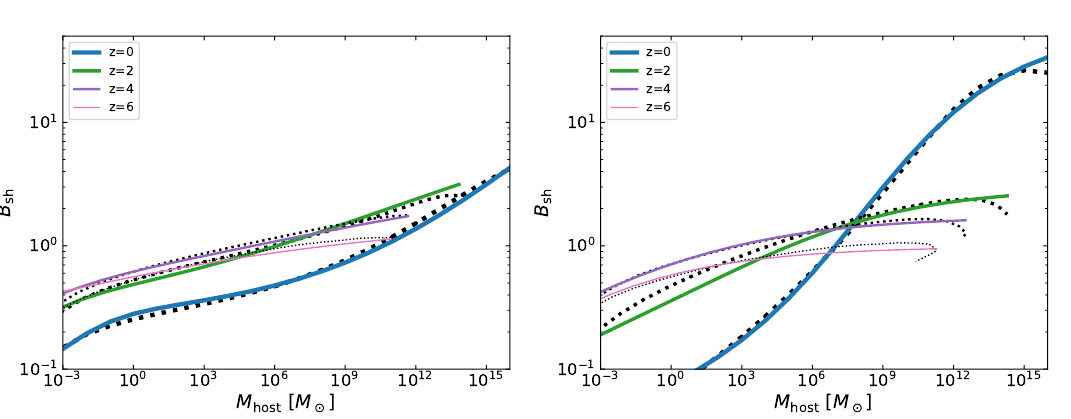
Figure A3. Comparisons between the boost factor from our calculations in Reference [50] and the fitting functions in this section. The left panel is the result assuming the concentration-mass relation in Reference [64] while the right panel assuming the relation in Reference